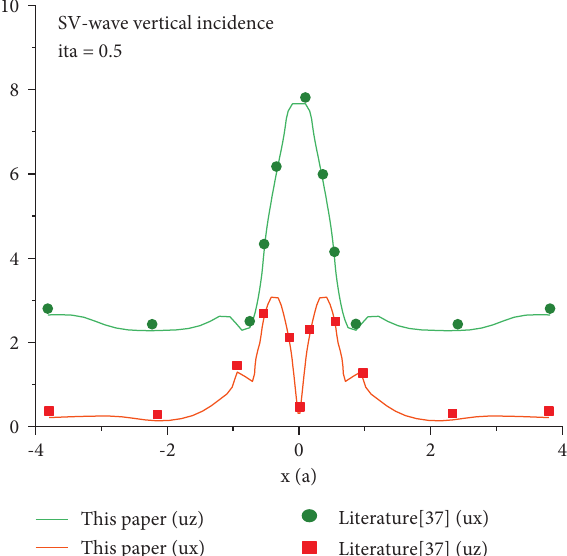
Figure 8: SV-wave vertical incidence surface displacement am- plitude ( Y � 0 and Z �